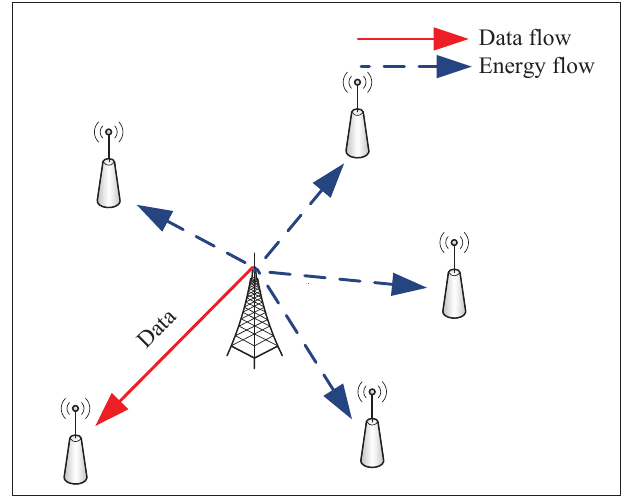
Figure 1. Multiuser SWIPT